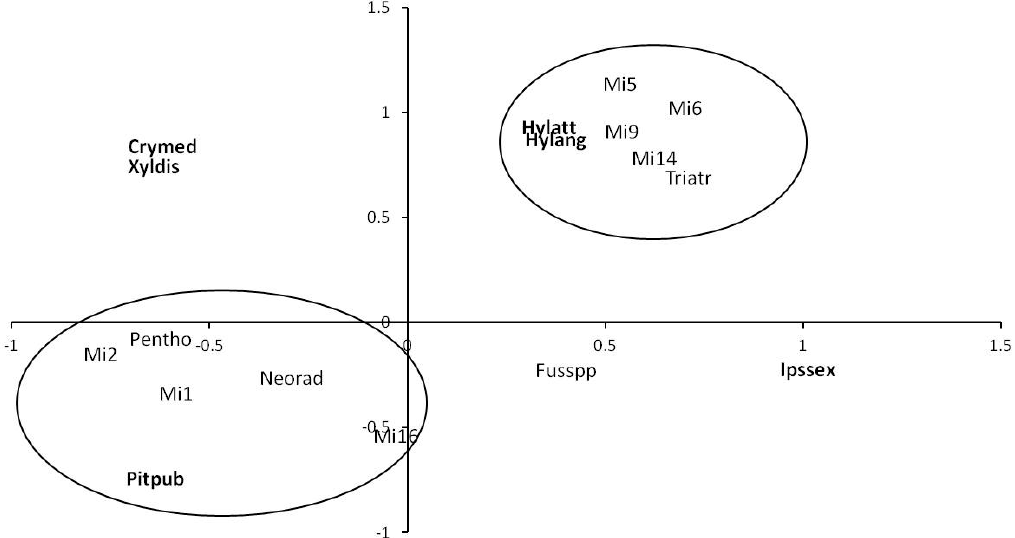
Figure 4. NMDS at insect species level. Fungal species (Triatr = T. atroviride , Pentho = P. thomentosum , Neorad = N. radicicola , Fusspp = Fusarium spp.) correspond to those isolated from insects collected from funnels and logs (Crymed = C. mediterraneus , Hylang = H. angustatus , Hylatt = H. attenuatus , Ipssex = I. sexdentatus , Pitpub = P. pubescens , Xyldis = X. dispar ). Dissimilarity distance = Bray–Curtis. Fungal communities from the insects collected from logs differed significantly (A = 0.3538, p < 0.001) from those associated with log tissues. Thus, two distinct groups of fungi were observed: one